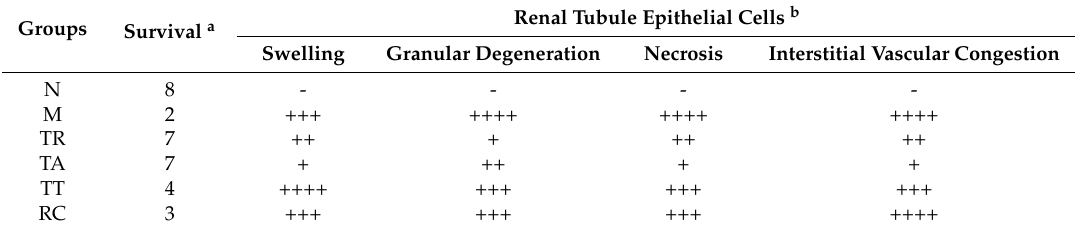
Figure 1. Rhubarb extract protects against body weight and urine volume declines induced by HgCl 2 injection. ( A ) Comparison of the body weight change of surviving rats in the different groups during the experiment. The body weight of HgCl 2 -injured rat groups stopped increasing and even decreased from the second day after the injection of HgCl 2 . The body weights of the total extract of rhubarb (TR), the total anthraquinones (TA) and the total tannins (TT) groups changed less than those in the HgCl 2 alone group and the remaining components group (RC); ( B ) Comparison of the 12 h urine volume of surviving rats in the different groups at 48 h after HgCl 2 injection. The urinary volumes decreased notably after HgCl 2 intoxication. However, the urinary volumes of rats in the TR and TA groups were non-significantly different to the N group. ** p < 0.01 vs. group N; # p < 0.05 vs. group M. Table 1. Survival and pathological alterations by treatment of each rhubarb extract against HgCl 2 -induced acute renal